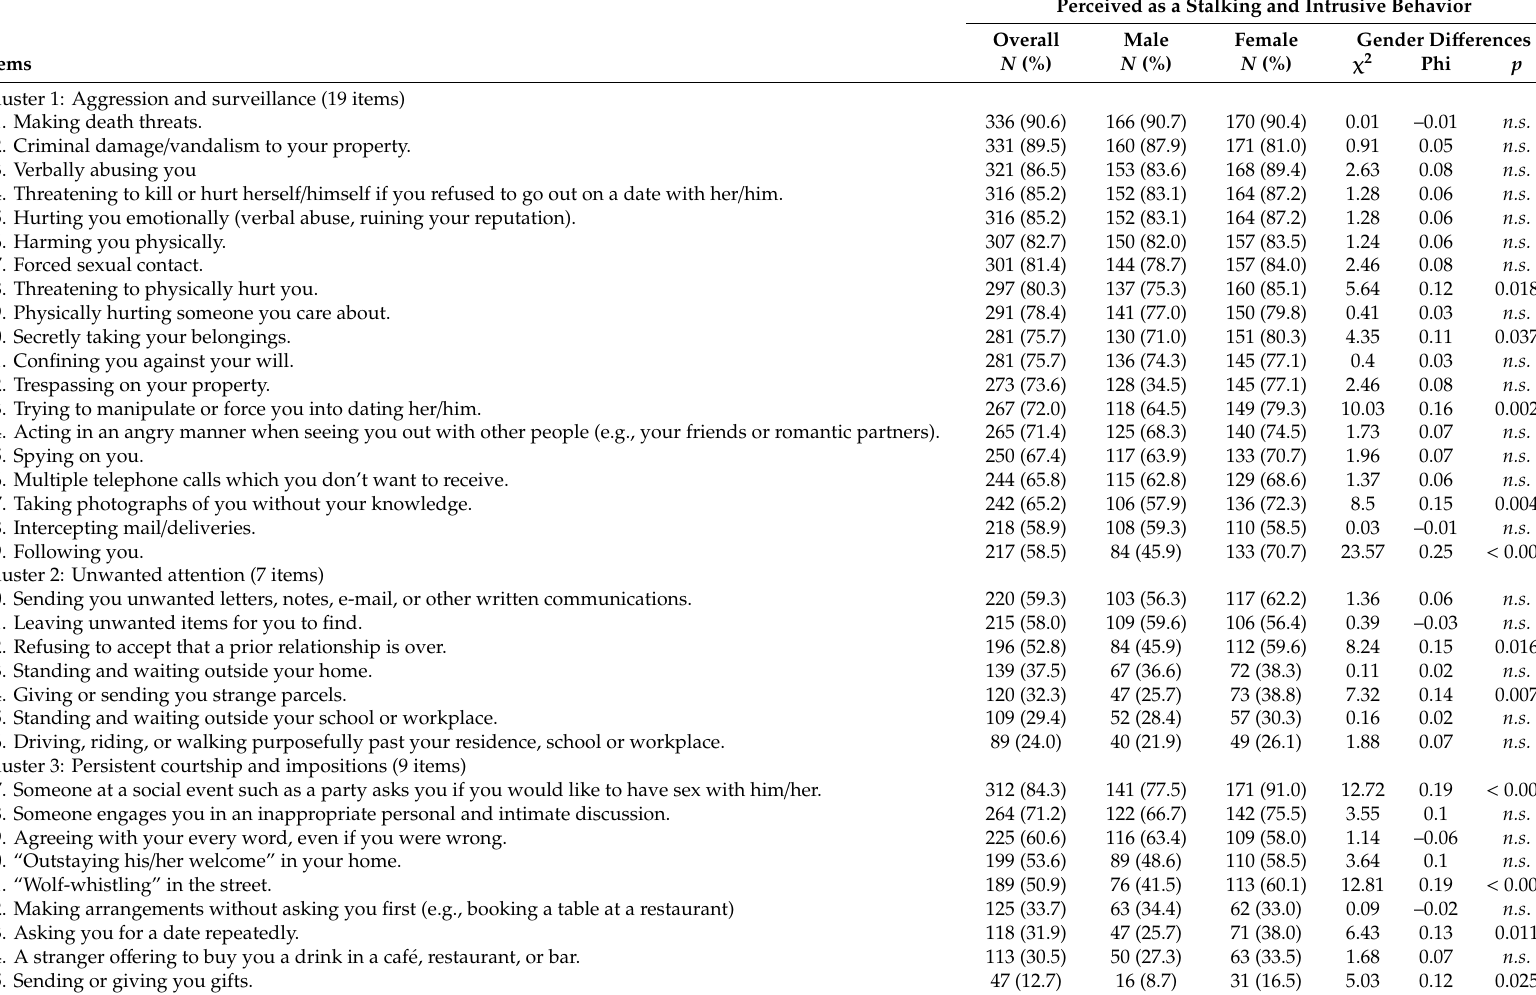
Table 1. Gender di ff erences on perceptions of stalking and intrusive behavior ( N = 371).